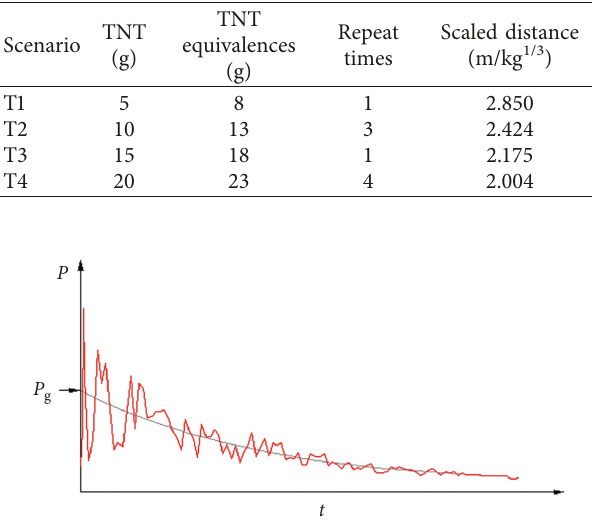
Figure 5: Gas pressure of confined blast loading (from